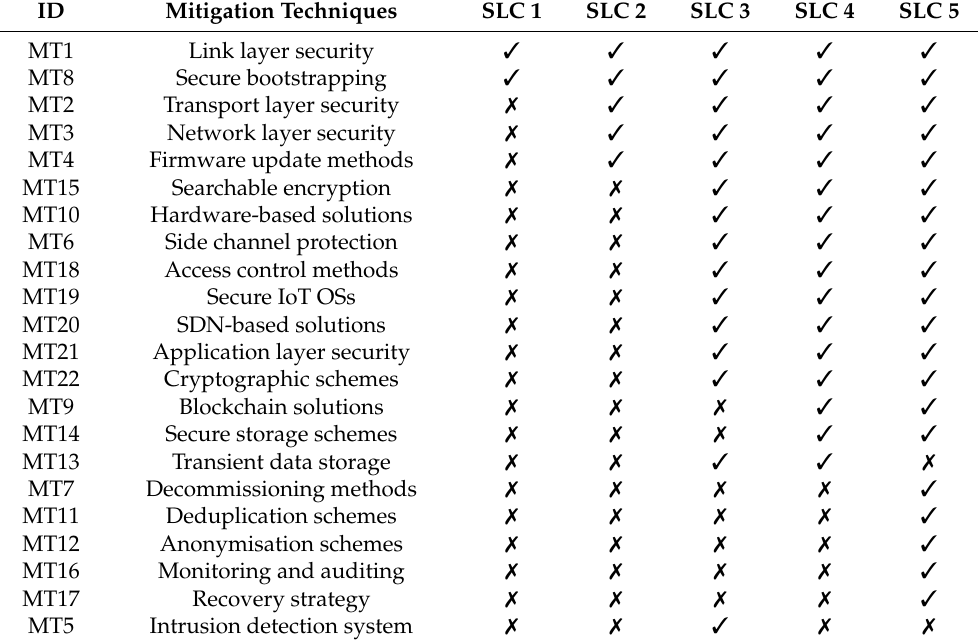
Table 10. SLCs classification according to the implementation of the mitigation techniques.